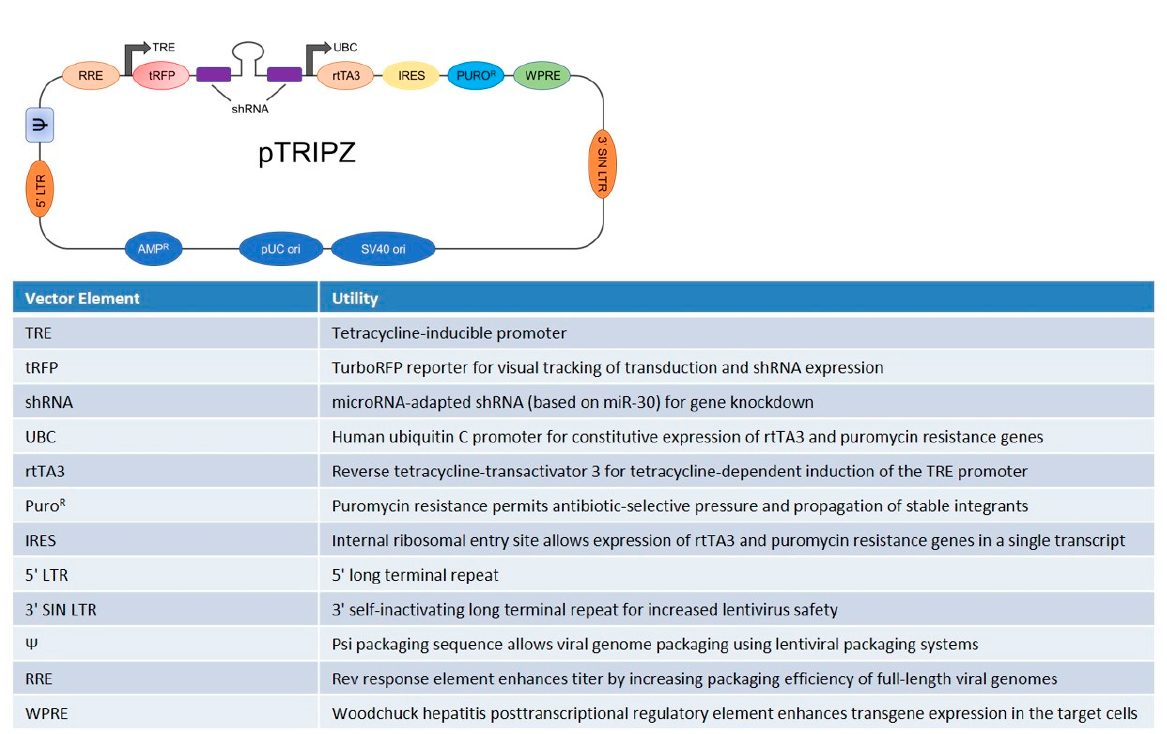
Figure 1. Schematic reproduction and features of the pTRIPZ Inducible Lentiviral shRNA vector.